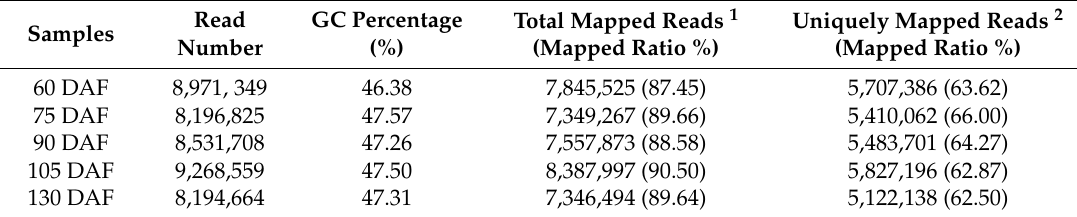
Table 1. Summary of DGE sequencing data and mapping results during different fruit development stages of L. cubeba .